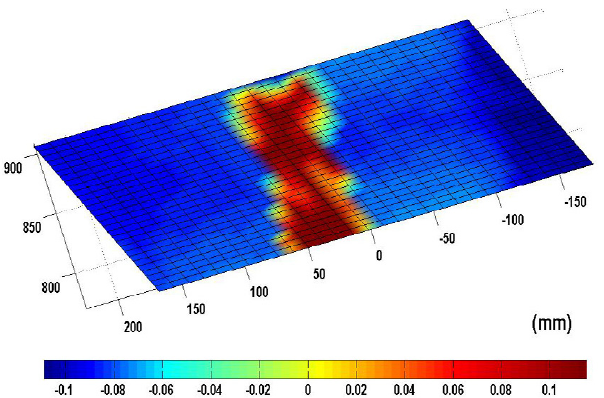
Fig. 2. Pattern of form deviations developed by MDZ evalua- tion of 148 772 data points.